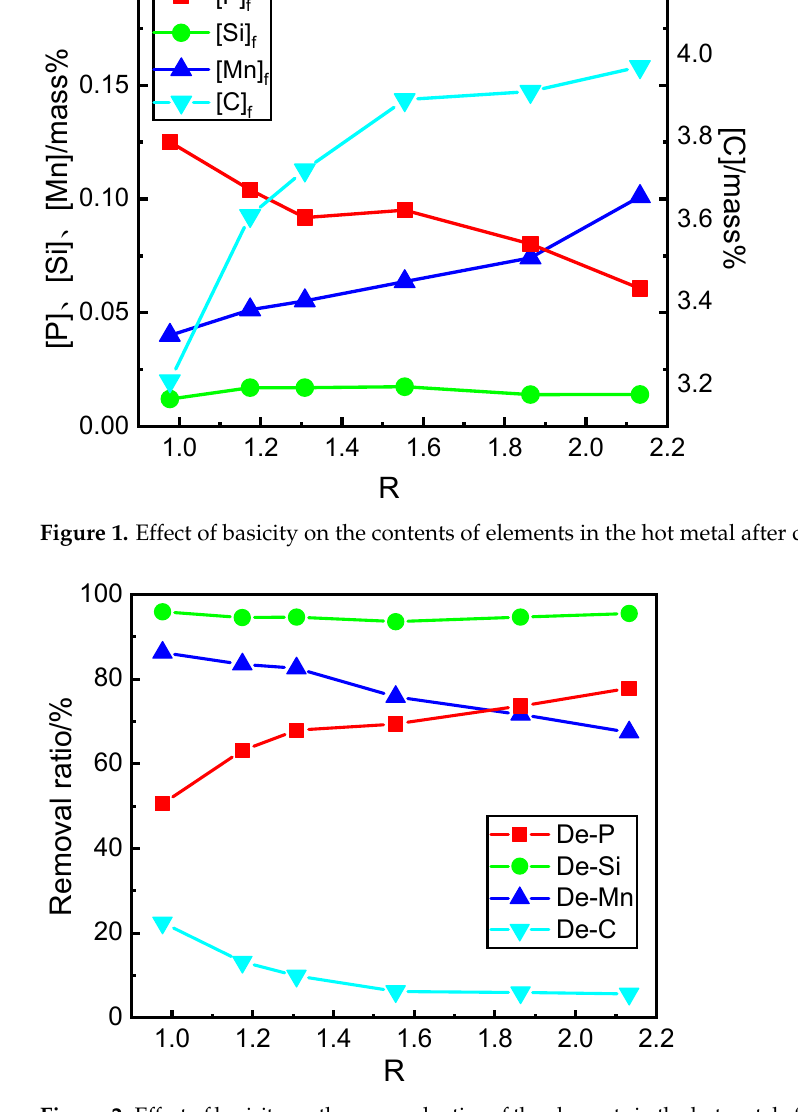
Figure 2. Effect of basicity on the removal ratios of the elements in the hot metal after dephospho- rization.